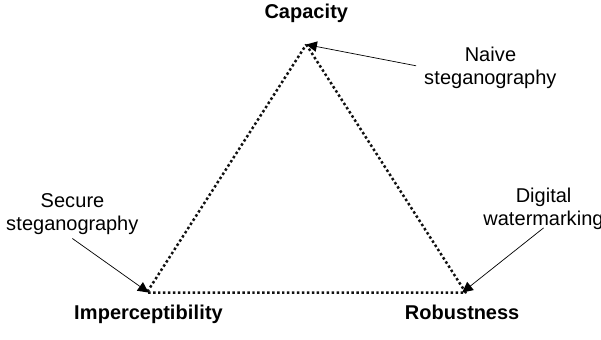
Figure 1. “Magic triangle of steganography.”